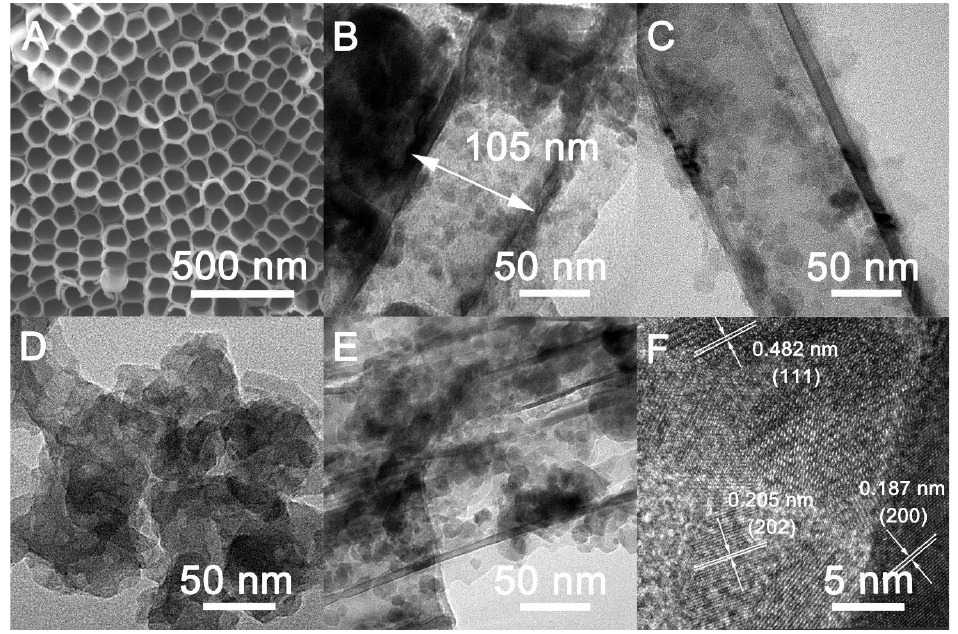
Figure 2. SEM and HRTEM morphologies for the samples. ( A ) SEM image of anodized TNT; ( B ) HRTEM image of 0.5FeTi; ( C ) HRTEM image of 1FeTi; ( D ) HRTEM image of Fe 2 O 3 ; ( E ) HRTEM image of 2FeTi; ( F ) HRTEM image of 1FeTi.